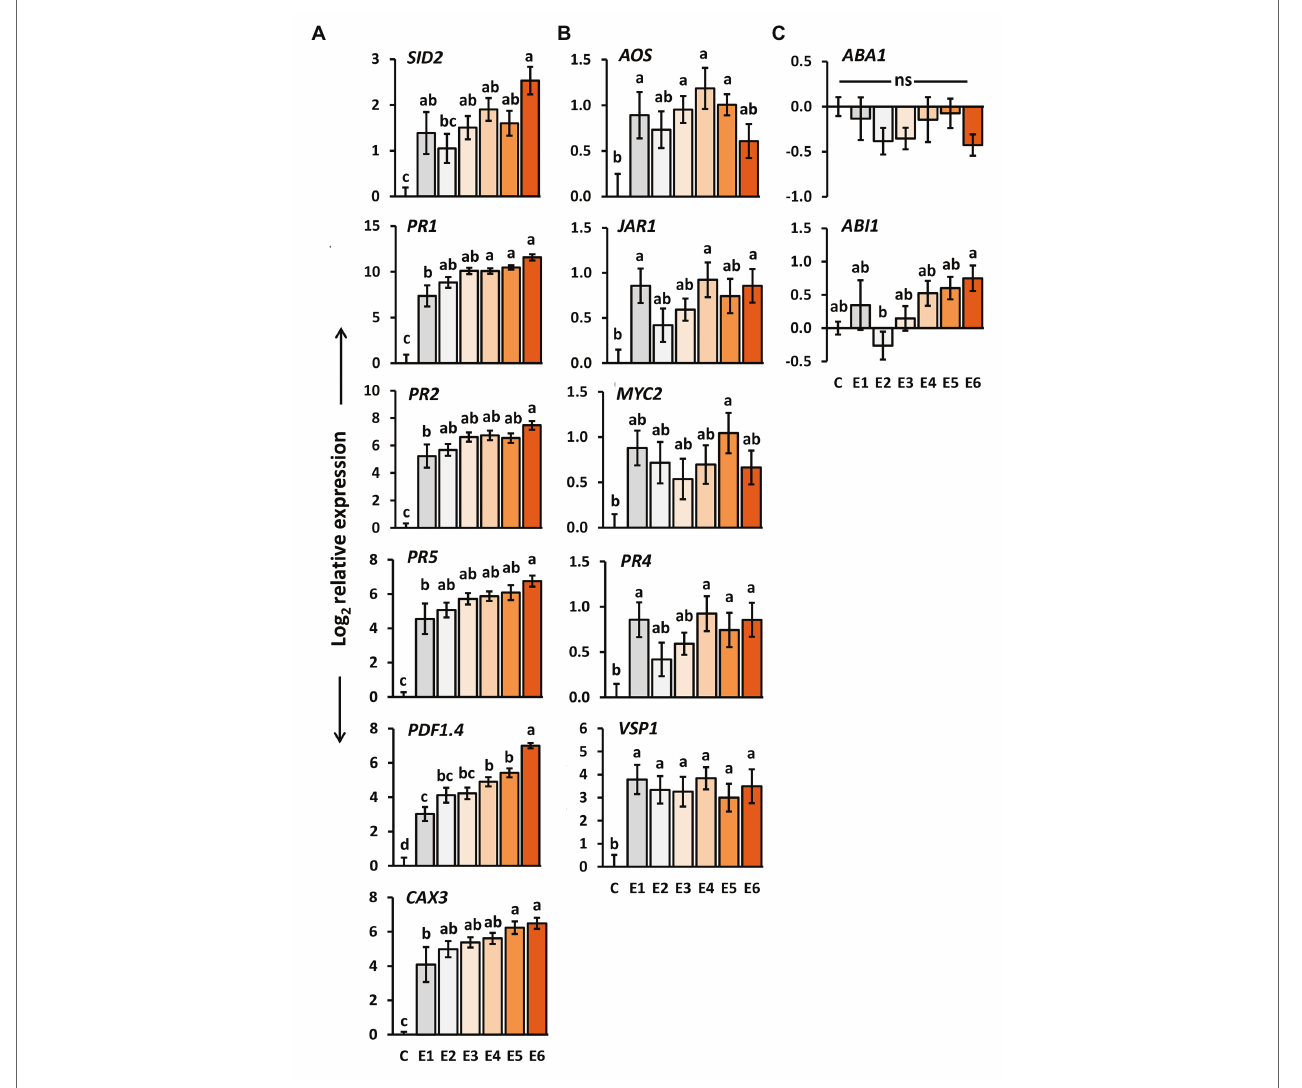
FIGURE 3 | Impact of P. brassicae egg deposition period on transcript levels in A. thaliana leaves. Relative gene expression (log 2 , mean ± SE) of genes known to be involved in (A) egg-mediated responses of A. thaliana , (B) jasmonic acid (JA) biosynthesis and responsive genes, (C) abscisic acid (ABA) biosynthesis and responsive genes in untreated plants (C) and plants exposed for 1 day (E1), 2 days (E2), 3 days (E3), 4 days (E4), 5 days (E5), or 6 days (E6) to P. brassicae eggs. Different letters indicate significant differences between treatments ( p < 0.05, linear mixed model and post hoc general linear hypothesis test with Tukey contrasts). Biological replicates (plants) per treatment: N =